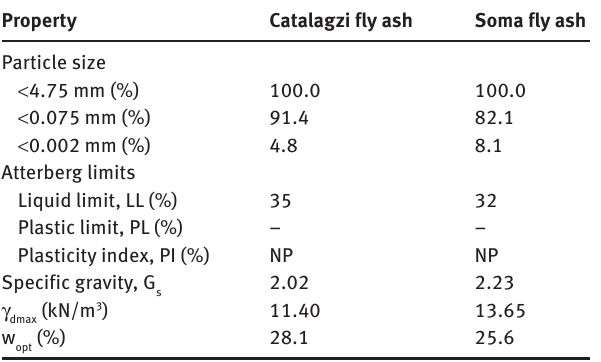
Table 3: Geotechnical properties of fly ashes used in the study. Property